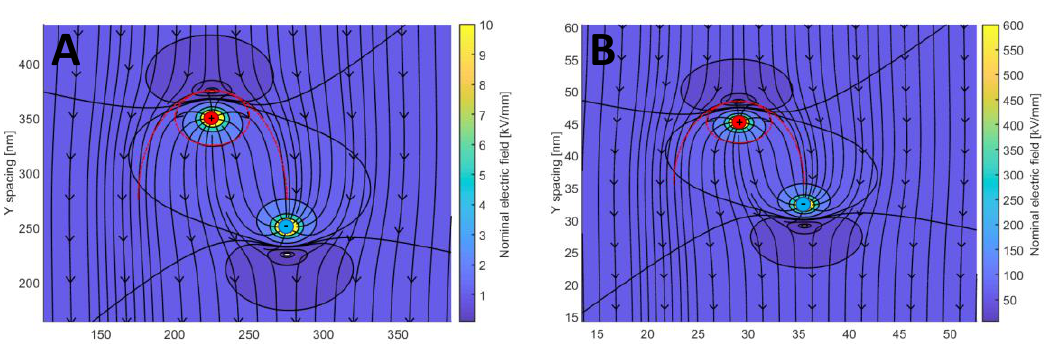
Figure 4. Field plots showing interaction of two opposite charge carriers in a background field of 1 kV/mm ( A , left) and 60 kV/mm ( B , right). The red circle is calculated using the critical recombination radius r cr according to Equation (21) and the half ellipsoid highlights the capture cross-section radius calculated with r ar . Note that the charge carriers are positioned to be just within the capture cross-section, such that the spacing differs by around one order of magnitude. A relative permittivity of 2.3 is used.